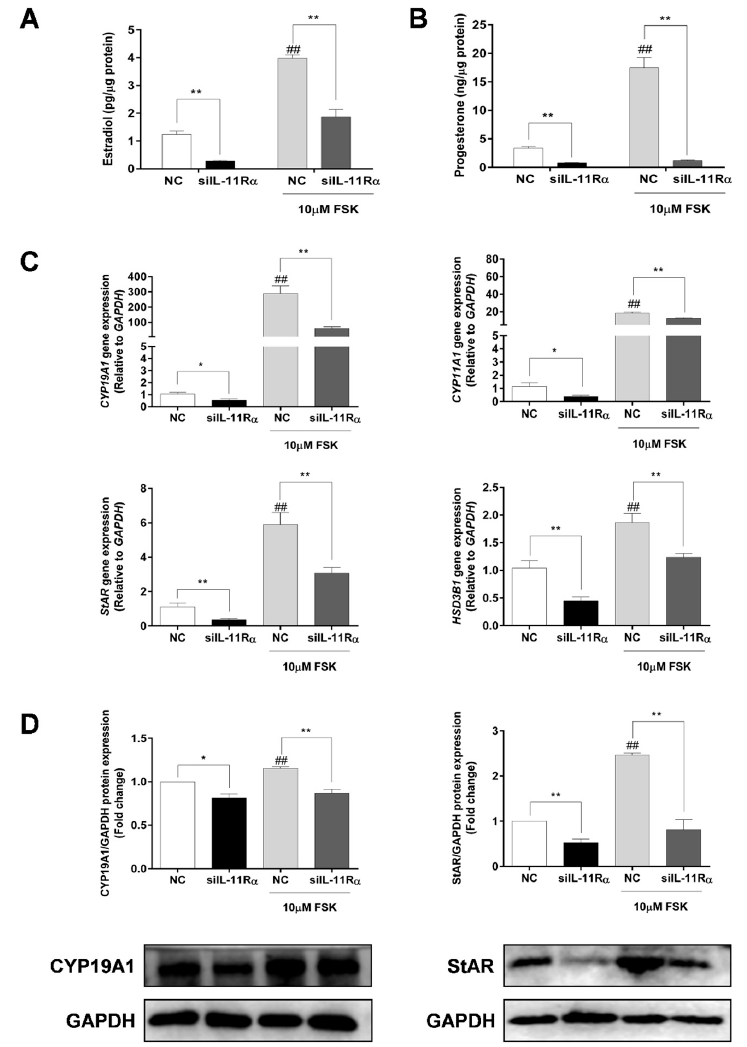
Figure 6. Effect of IL-11R α knockdown on steroidogenesis by bovine GCs after 48 h of siIL-11R α transfection. Estradiol ( A ) and progesterone ( B ) production in the presence or absence of 10 µ M FSK were determined by ELISA; data represent two independent experiments, each completed in triplicate. ( C ) The relative mRNA expression levels of CYP19A1 , CYP11A1 , StAR , and HSD3B transcripts in the presence or absence of 10 μ M FSK and normalized by GAPDH; data represent two independent experiments, each completed in triplicate. ( D ) The protein levels of CYP19A1 and StAR in the presence or absence of 10 μ M FSK were examined by Western blot; the quantitative results indicated fold changes in the CYP19A1/GAPDH and StAR/GAPDH ratios compared to the control and the representative Western blots from three independent experiments are shown. * p < 0.05 and ** p < 0.01 between the indicated groups. ## p < 0.01 between the negative control (-FSK) and the FSK treatment-alone groups.